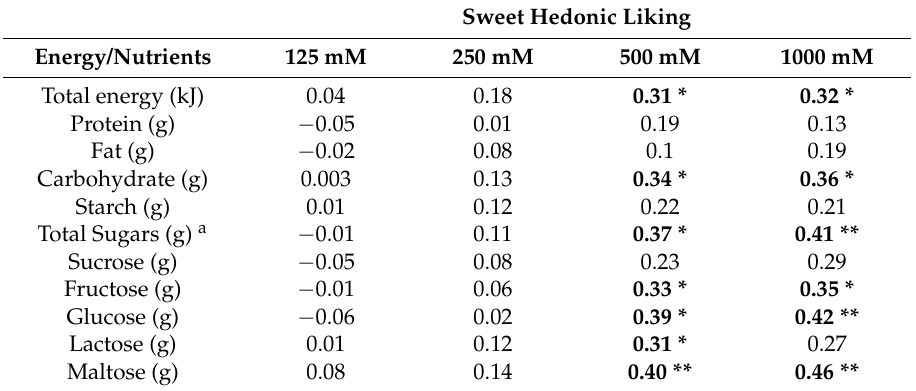
Table 7. Correlation coefficients of the relationship between sweet hedonic liking and food intake.